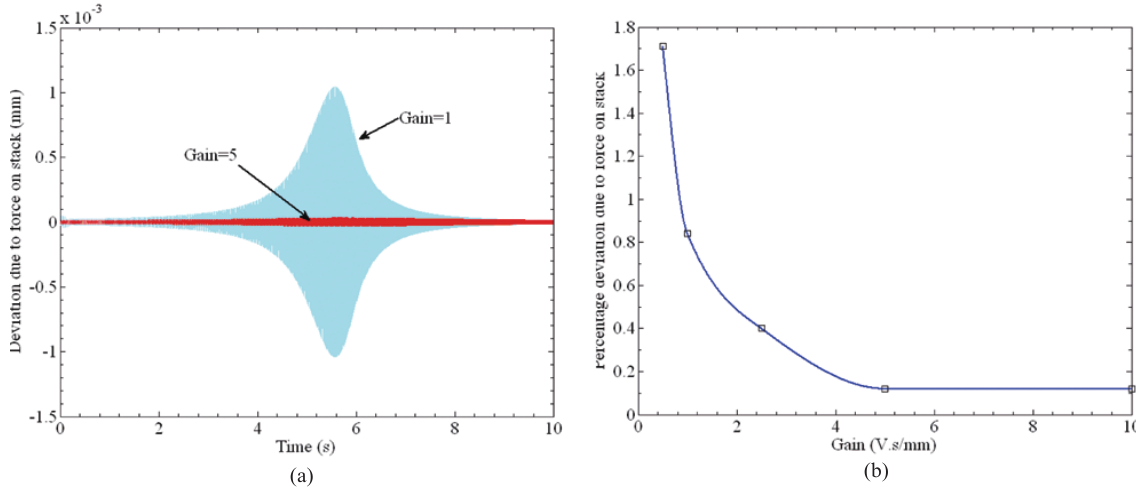
Fig. 12. (a) Deviation of results when forces on the stacks are neglected from the full non-linear analysis and (b) maximum deviation as a percentage of maximum amplitude. actuator given by Eq. (12) now need be